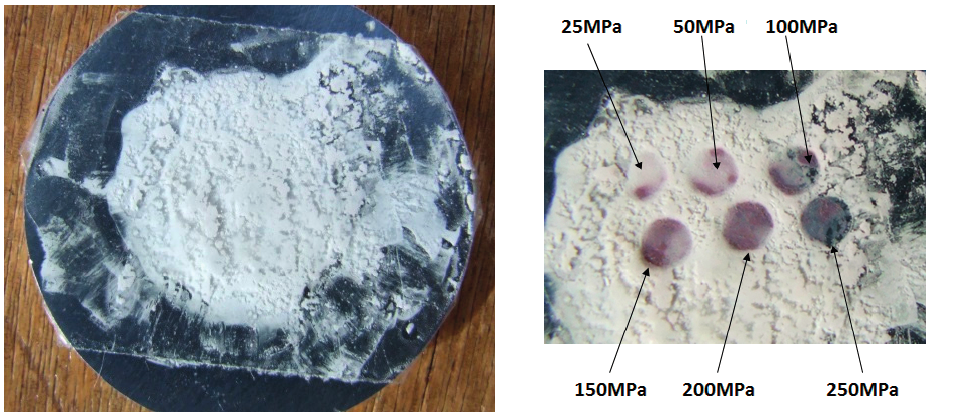
Figure 5. ( Left ) Sample holder showing the SCO compound at room temperature on its sample holder covered with a scotch tape; ( Right ) Enlarged view of the sample evidencing colour change to pink at room temperature for various applied pressures (25 MPa, 50 MPa, 100 MPa, 150 MPa, 200 MPa and 250